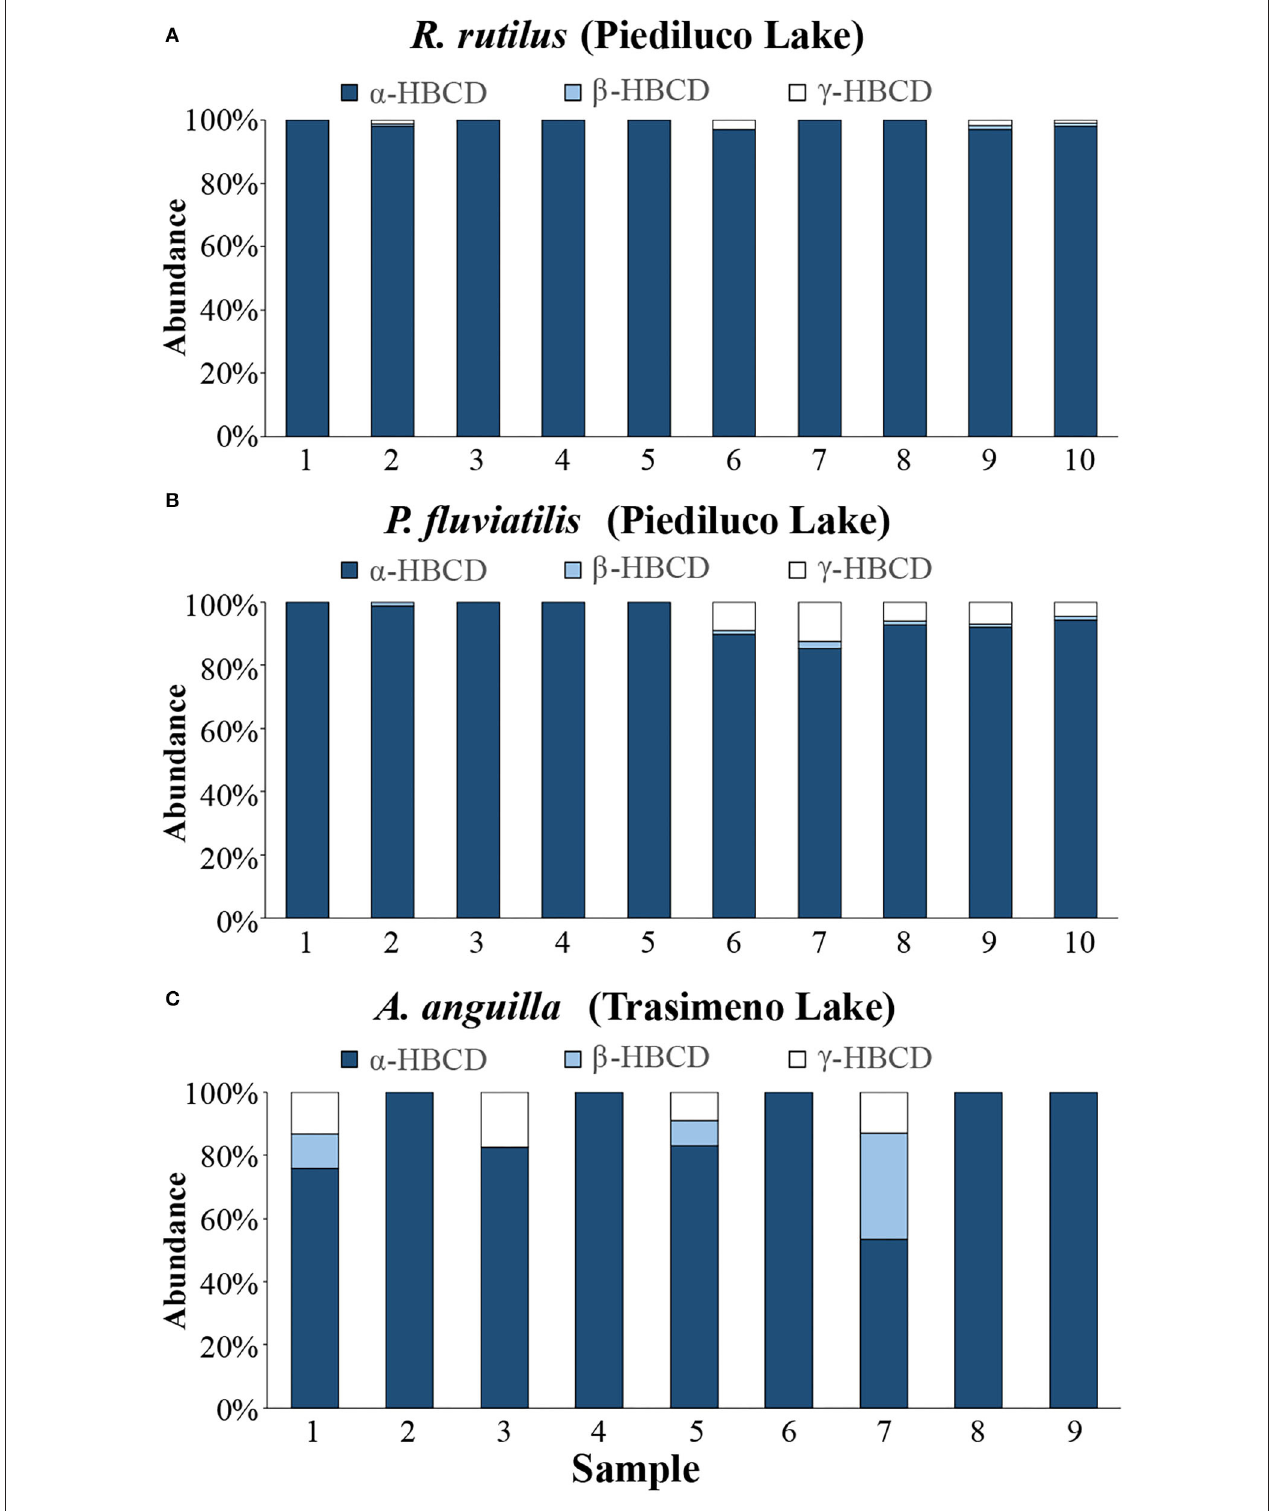
FIGURE 6 | HBCDs contamination patterns (abundance ratio for the α -, β -, γ -HBCD isomers) in muscle of (A) Rutilus rutilus and (B) Perca fluviatilis sampled in Piediluco Lake and in (C) Anguilla anguilla sampled in Trasimeno Lake.